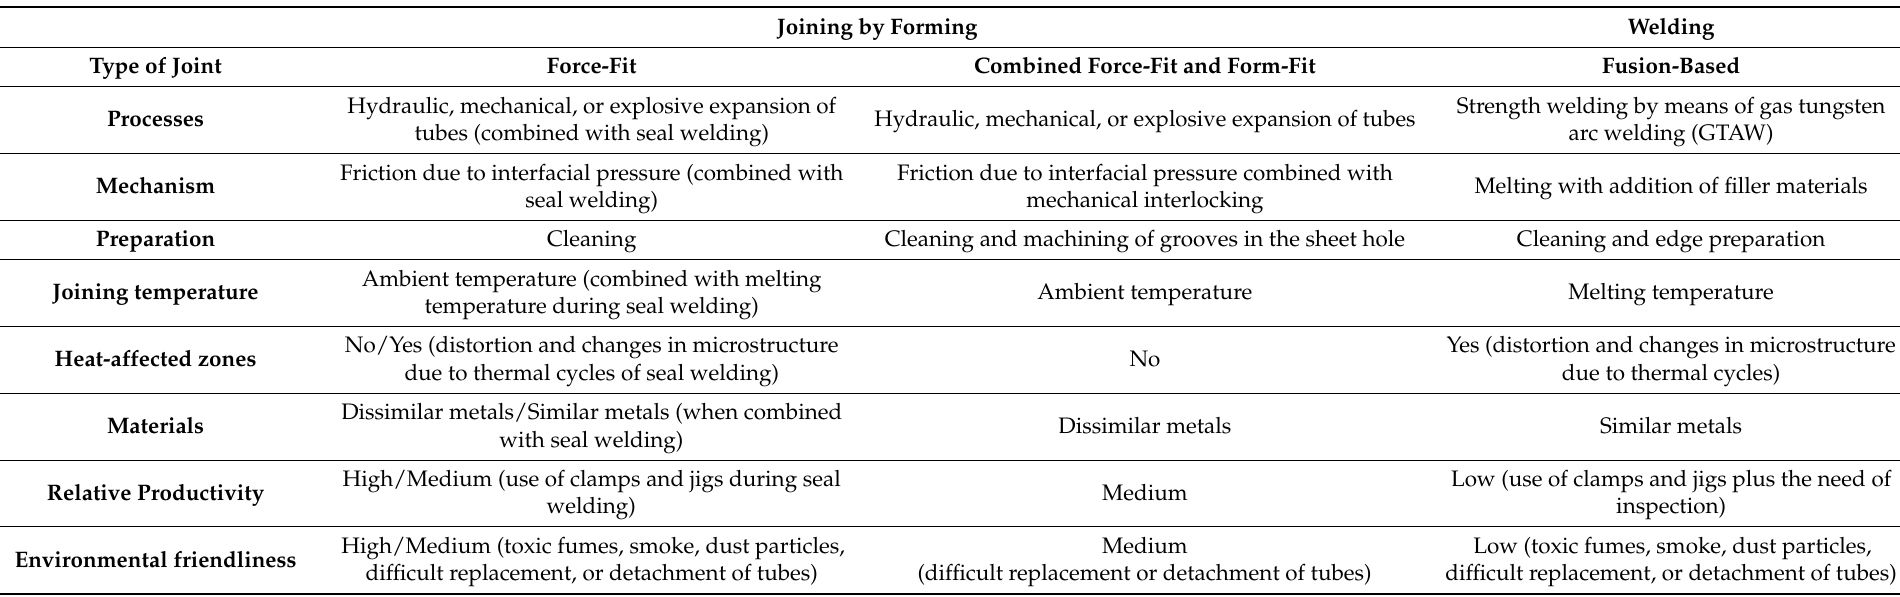
Table 1. Main characteristics and features of the processes for attaching metal sheets to metal tube